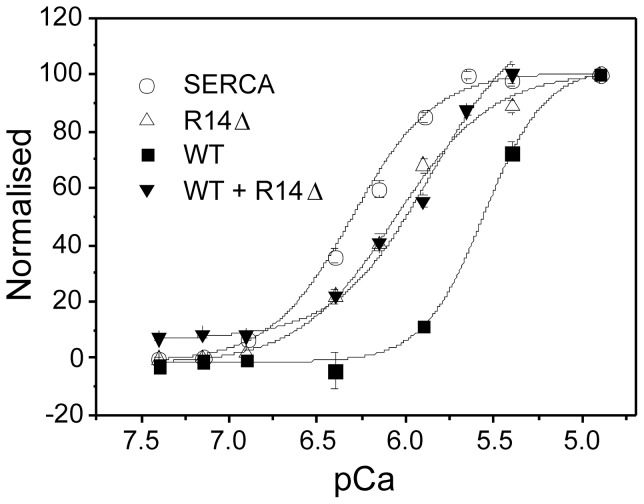
ATPase activity of SERCA:Normalised ATP hydrolysis by SERCA alone (open circles), or reconstituted with full-length recombinant PLBWT (squares), PLBR14Δ (open triangles), or an equimolar mix of mutant and WT (inverted triangles), with activity measured as a function of calcium concentration (n = 6). Samples were reconstituted with the enzyme in DOPC membranes at a lipid/protein/enzyme ratio of 160:2:1 and activities were determined in real time using the coupled enzyme assay.